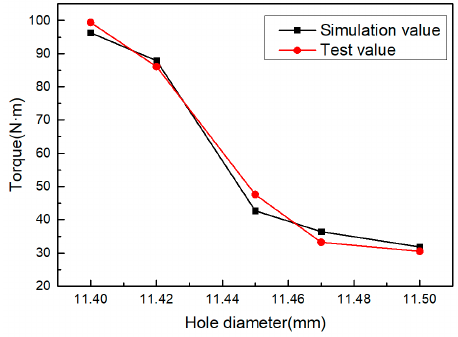
Figure 8. E ff ect of hole diameter on Figure 8. Effect of hole diameter on torque.